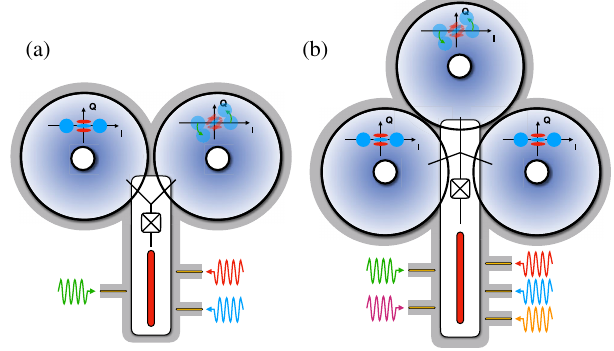
FIG. 11. Proposal for an experimental implementation of bias- preserving CNOT and Toffoli gates for cat qubits. (a) Setup for implementing a bias-preserving CNOT gate. The cat qubits are encoded in high- Q cylindrical postcavities (in blue, resonance frequencies ω and ω ). The two cavities are coupled via a a b Y -shape transmon as in Ref. [58] to a low- Q strip-line resonator (in red, resonance frequency ω ) playing the role of the dump d mode. The system is driven with three microwave pumps at (b) A similar setup for implementing a bias-preserving Toffoli gate with three cat qubits encoded in high- Q postcavities (frequencies ω , ω , and ω ) all coupled to a single strip-line a b c ). The system is driven with five micro- resonator (frequency ω d − ω wave pumps at frequencies ω 1 ¼ 2 ω , ω 2 ¼ ω c d a þ